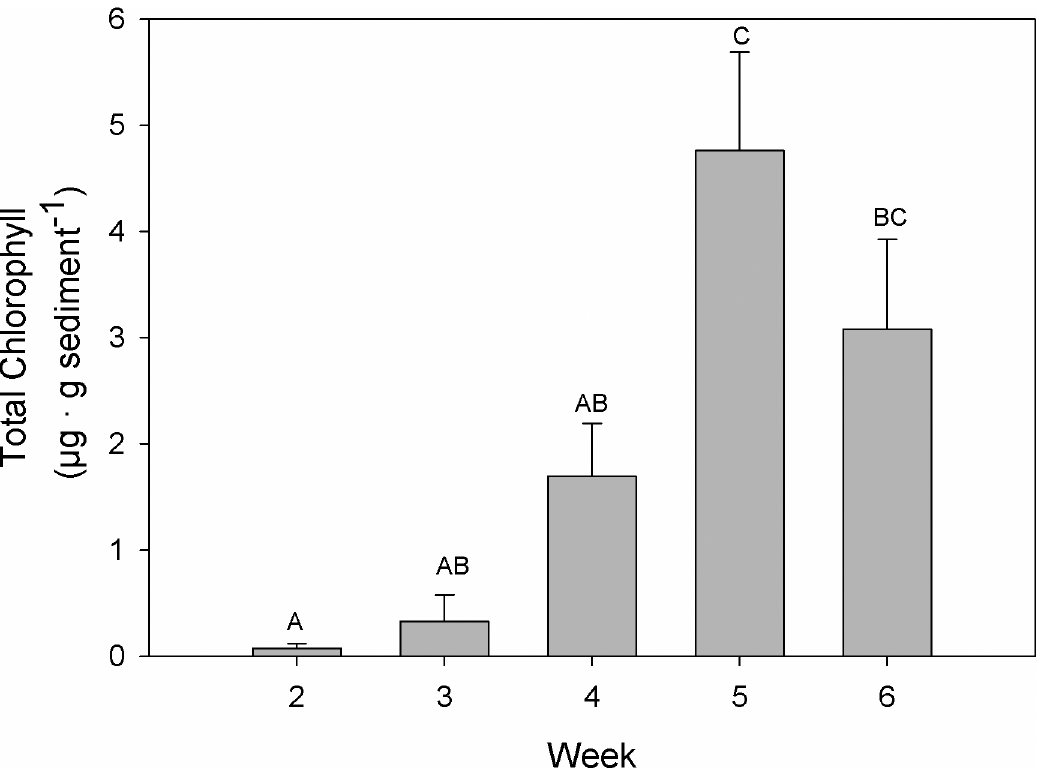
Fig 4. Biomass of benthic microalgae. Each bar represents pooled data from all treatments since there were no significant differences in biomass among treatments. Letters above the bars represent significant differences among weeks. Mean values ± 1 SE (n =